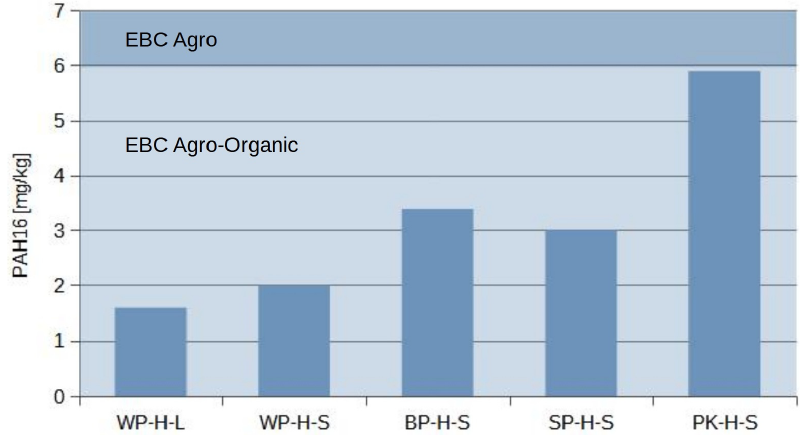
Figure 9. PAH16 content of the produced biochar by the Apeli stove.